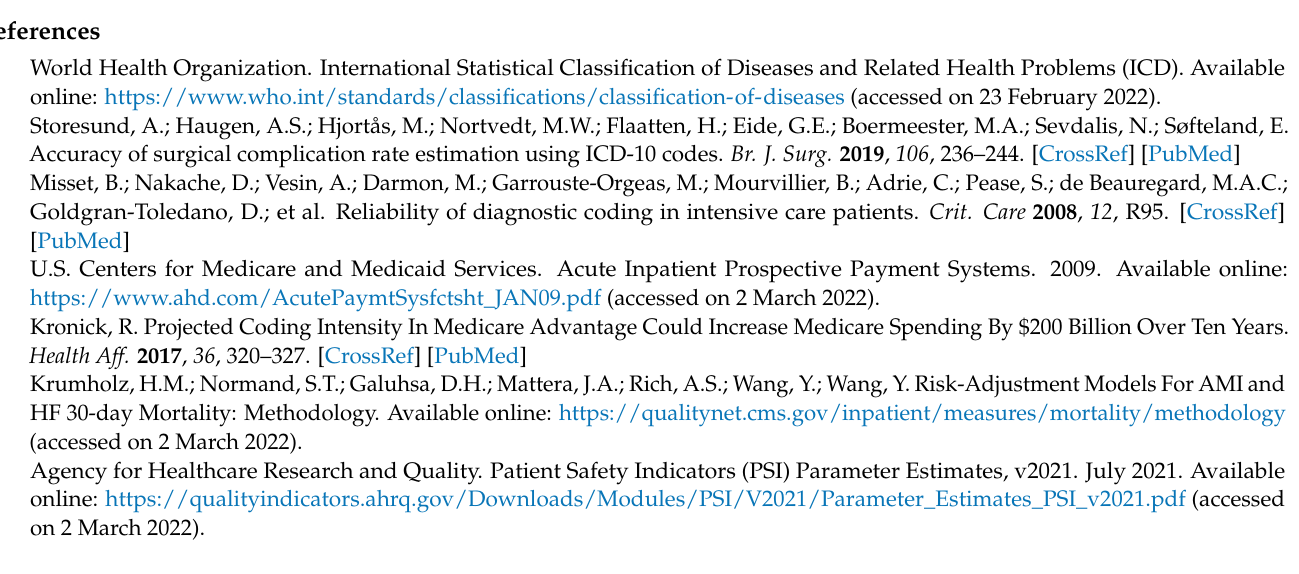
status; Figure S6: Effect plot of excess coding intensity by facility ownership; Figure S7: Effect plot intensity by facility teaching status; Figure S9: Effect plot of excess coding intensity by facility academic status; Figure S10: Effect plot of excess coding intensity by facility U.S. Census regional division; Figure S11: Effect plot of excess coding intensity by facility bed count; Figure S12: Heatmap of AECI seasonality by admission month and facility region based on the U.S. Census Bureau definition of 9 regional divisions; Figure S13: Effect plot of adjusted excess coding intensity (AECI) by facility; Figure S14: Sorted dot plot of adjusted excess coding intensity (AECI) across